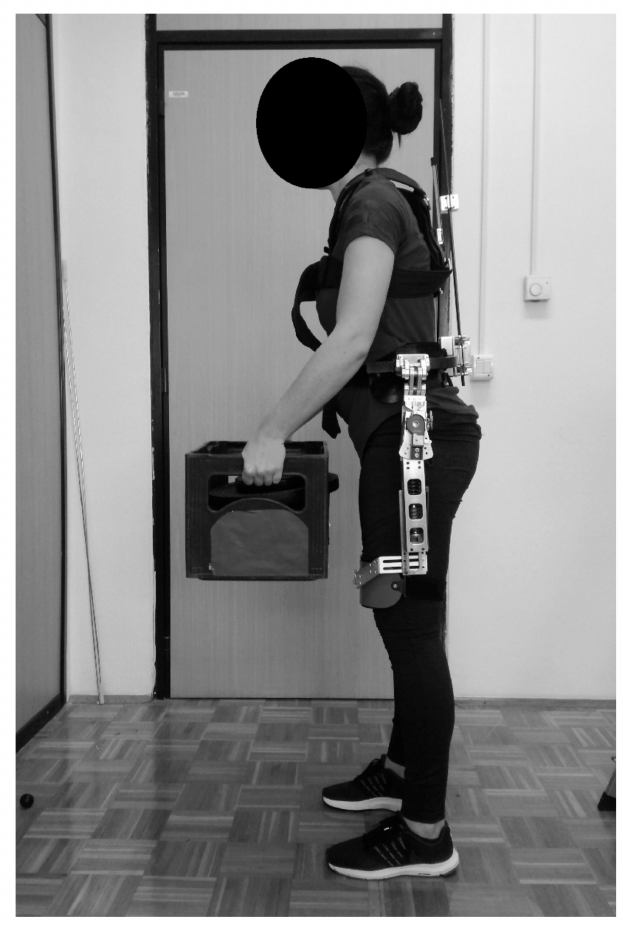
Figure 1. SPEXOR passive spinal exoskeleton, as used during a lifting